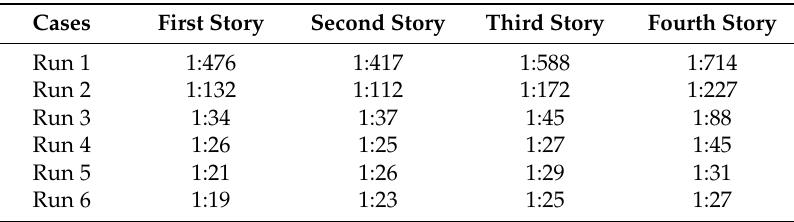
Table 5. Maximum inter-story drift ratio.